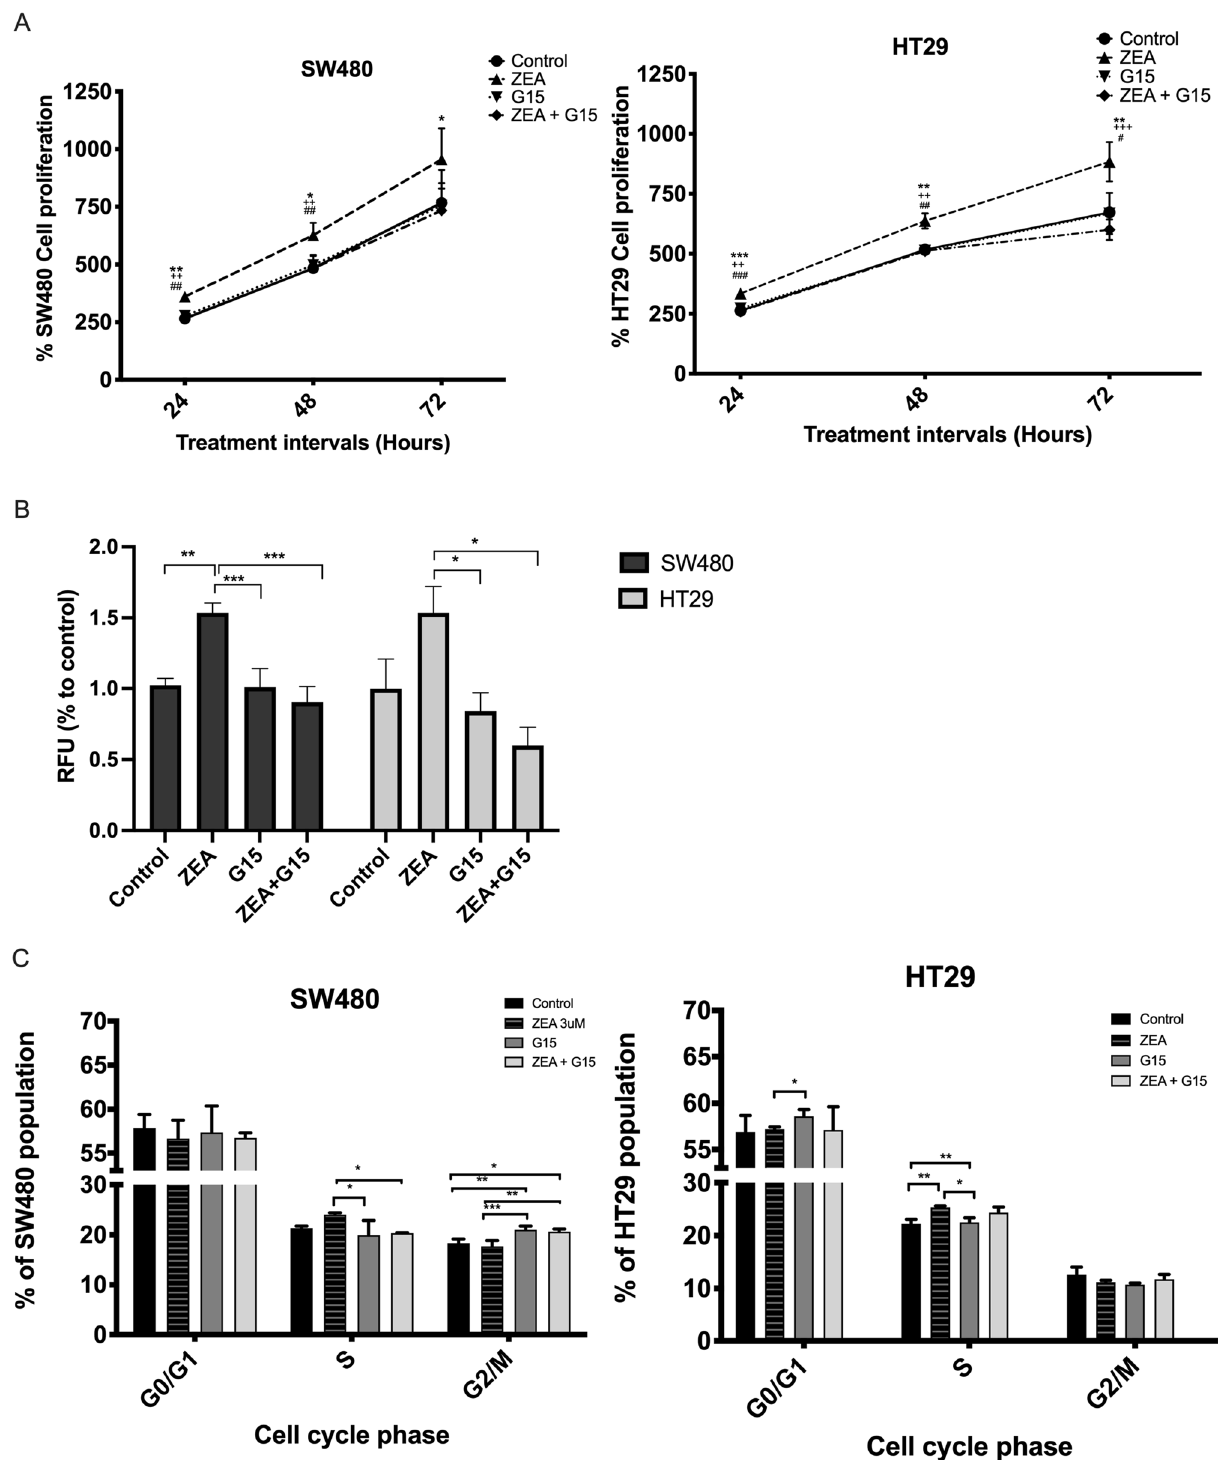
Figure 3. Zearalenone promoted the growth of human CRC cells. ( A ) SW480 and HT29 cells were incubated with 3 μM ZEA with or without G15 (GPER antagonist) for 24, 48 and 72 h. CRCs were then trypsinized and fixed with trypan blue solution. Cell counting was carried out using LUNA Automated Cell Counter. *p < 0.05, **p < 0.01 and ***p < 0.001 ZEA compared to control. + p < 0.05, ++ p < 0.01 and +++ p < 0.001 G15 compared to ZEA. # p < 0.05, ## p < 0.01 and ### p < 0.001 ZEA + G15 compared to ZEA. ( B ) Soft agar transformation assay was performed. RFU refers to Relative fluorescent units. ( C ) Cell cycle analysis of SW480 and HT29 co-incubated 3 μM ZEA with or without G15 for 24 h. The percentage of S phase, G0/G1 and G2/M are shown in the figures. Results shown are mean ± SEM, with n = 3. *p < 0.05, **p < 0.01 and ***p <